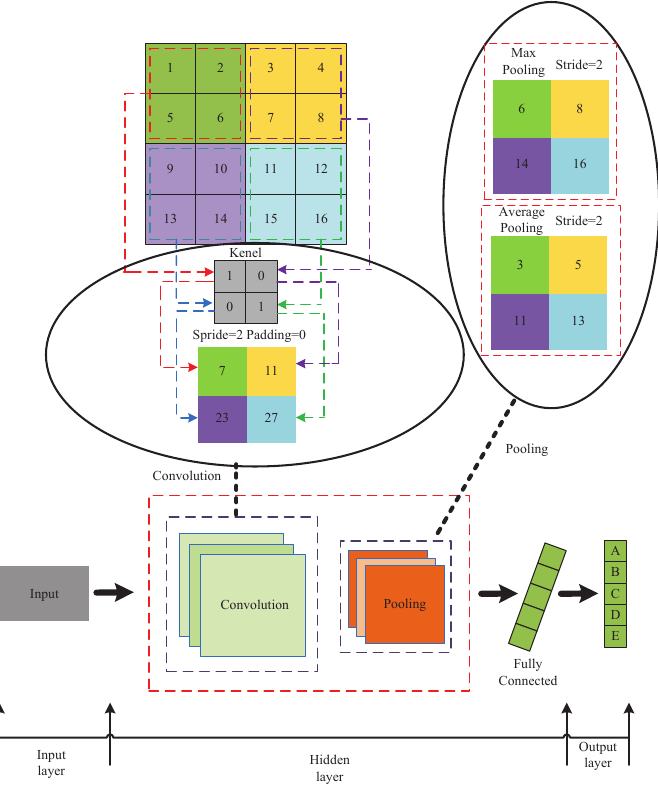
Figure 1. Structure of the